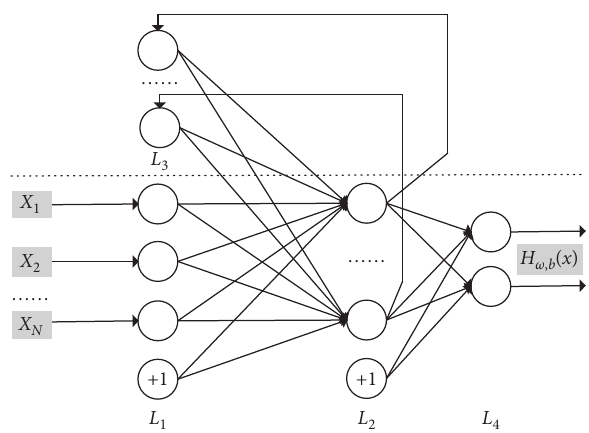
Figure 1: Elman neural network structure diagram.